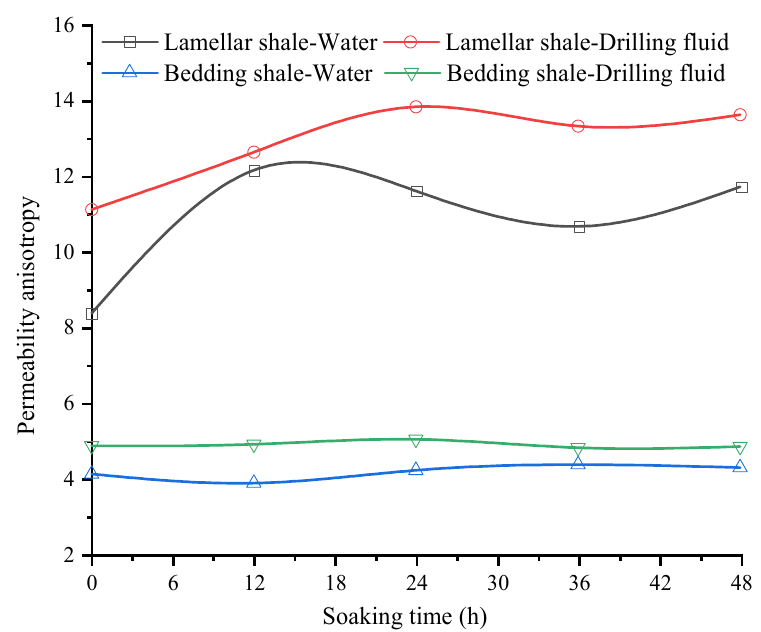
Figure 9. The influence of different lamina developments and soaking fluids on permeability anisotropy, the lamina density with sampling angle of 0 ◦ is 1, the lamina density with sampling angle of 90 ◦ is 2.